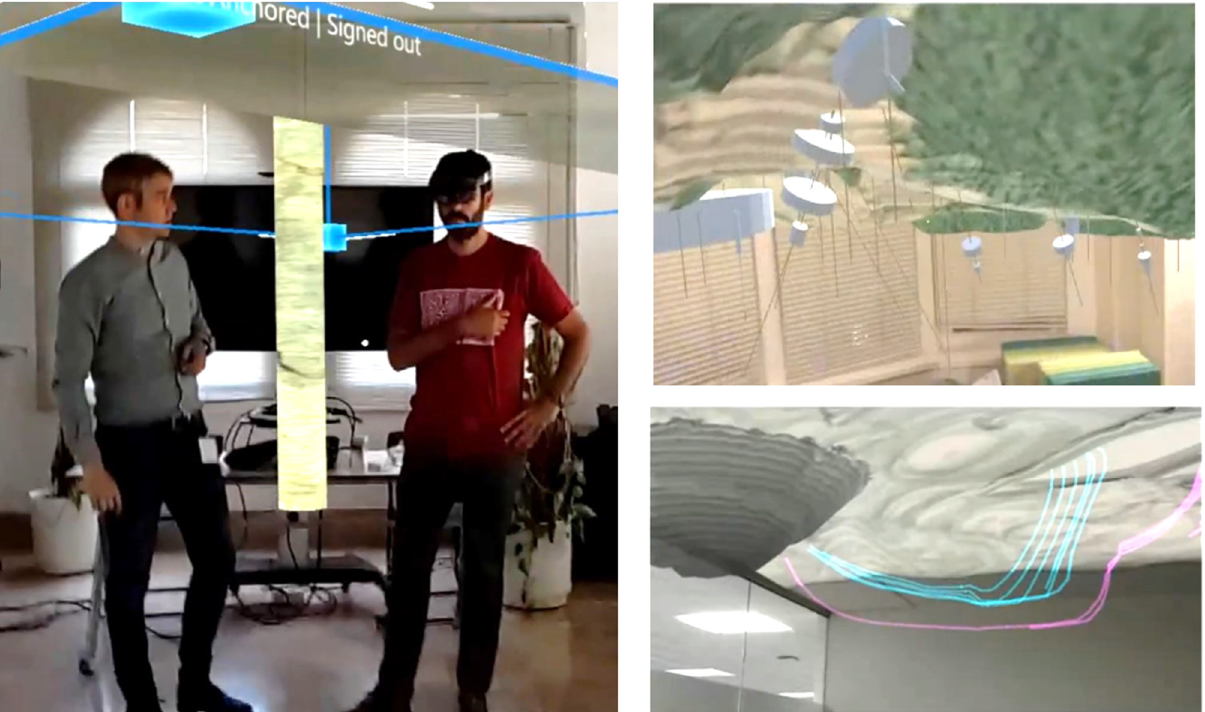
Figure 12. Examples of other underground data that can be shown as 3D holograms with the HoloLens 2. ( Left ) the light column in the image is a representation of the borehole wall as registered by an optical “televiewer” camera array. ( Upper right ) each dark line is a representation of a borehole, and each light gray disc is sized proportionally to the permeability measured at a given segment of the borehole (Lugeon test). ( Bottom right ) flowlines and particle velocity through the ground for an open pit (pictures courtesy of BGC/Clirio).